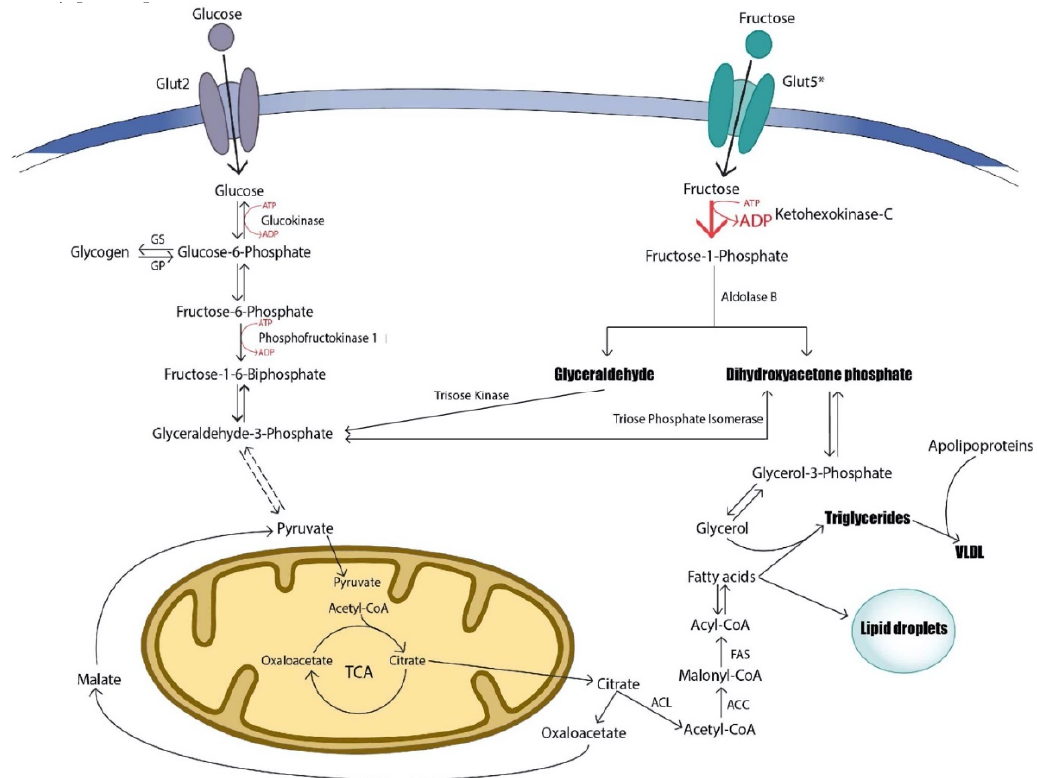
Figure 1. Glucose versus fructose metabolism. Glucose is transported though the Glut2 receptor in the liver and either stored as glycogen or metabolized through glycolysis to produce ATP and pyruvate. Fructose can be transported through Glut2 or Glut5 and is metabolized into trioses through the ATP-dependent enzyme, ketohexokinase-C. Glyceraldehyde and dihydroxyacetone phosphate (DHAP) may be converted to glyceraldehyde-3-phosphate to produce pyruvate or to produce fructose-1,6-biophosphate for gluconeogenesis, or alternatively may directly fuel triglyceride synthesis. The rapid conversion of fructose into trioses may overstimulate the production of triglycerides and VLDL lipoproteins. ACC, acetyl-CoA carboxylase; ACL, ATP citrate lyase; ADP, adenosine diphosphate; ATP, adenosine triphosphate; FAS, fatty acid synthase; Glut2 / 5, glucose transporter 2 / 5; GS, glycogen synthase; GP, glycogen phosphorylase; TCA, citric acid cycle; VLDL, very low-density lipoprotein.